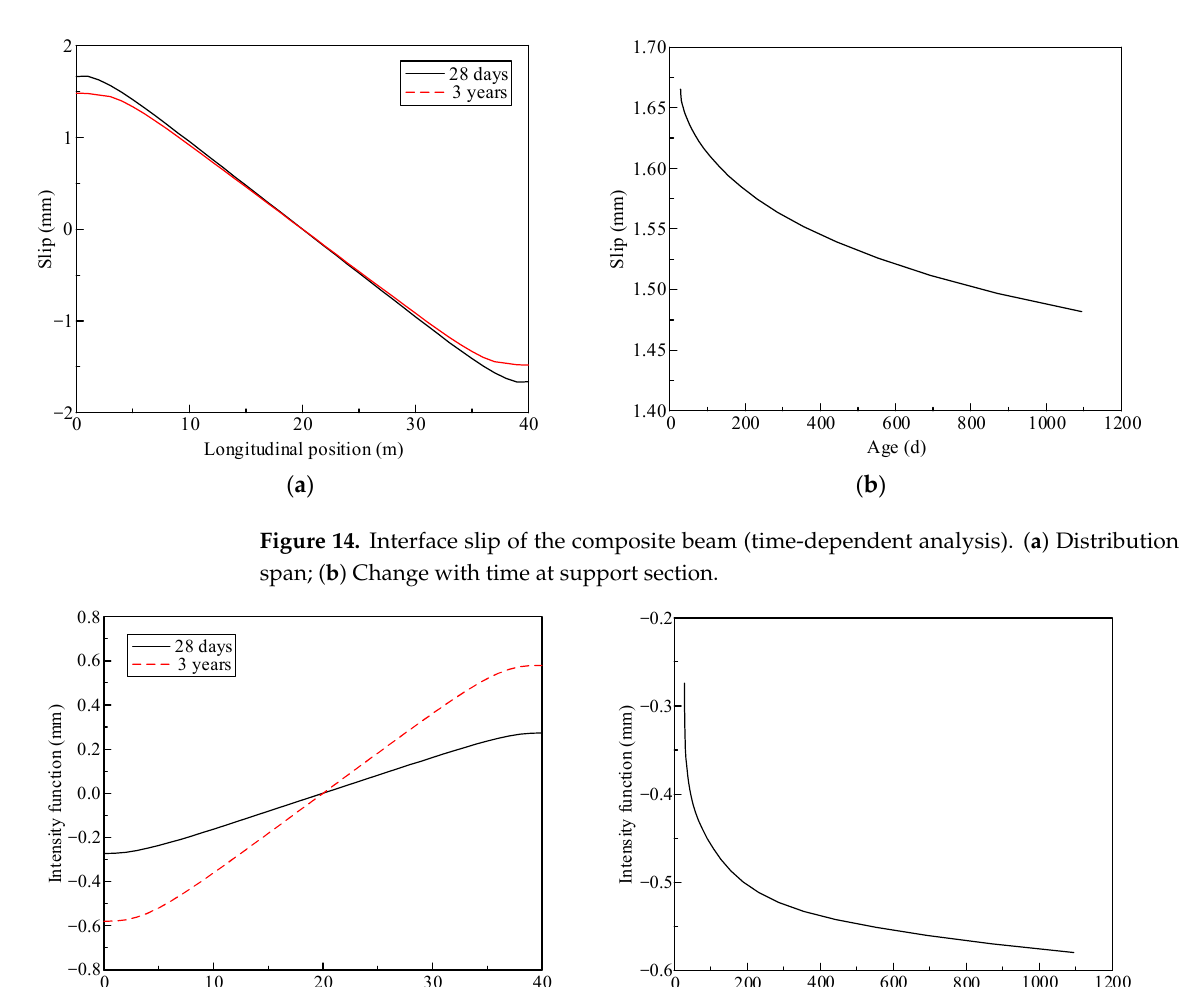
Figure 16 shows the time-dependent variations in the warping intensity function at the bottom flange of the steel beam due to shear deformation. As shown in Figure 16a, this response at the beam end in the 3rd year is 7.01% higher than that on the 28th day. Figure 16b shows the changes in the response at the composite beam end. The response at the support of the composite beam gradually increases over time, but in a narrower range. Figure 15. Warping intensity function of the concrete slab due to shear deformation of the composite beam (time-dependent analysis). ( a ) Distribution along span; ( b ) Change with time at support section.